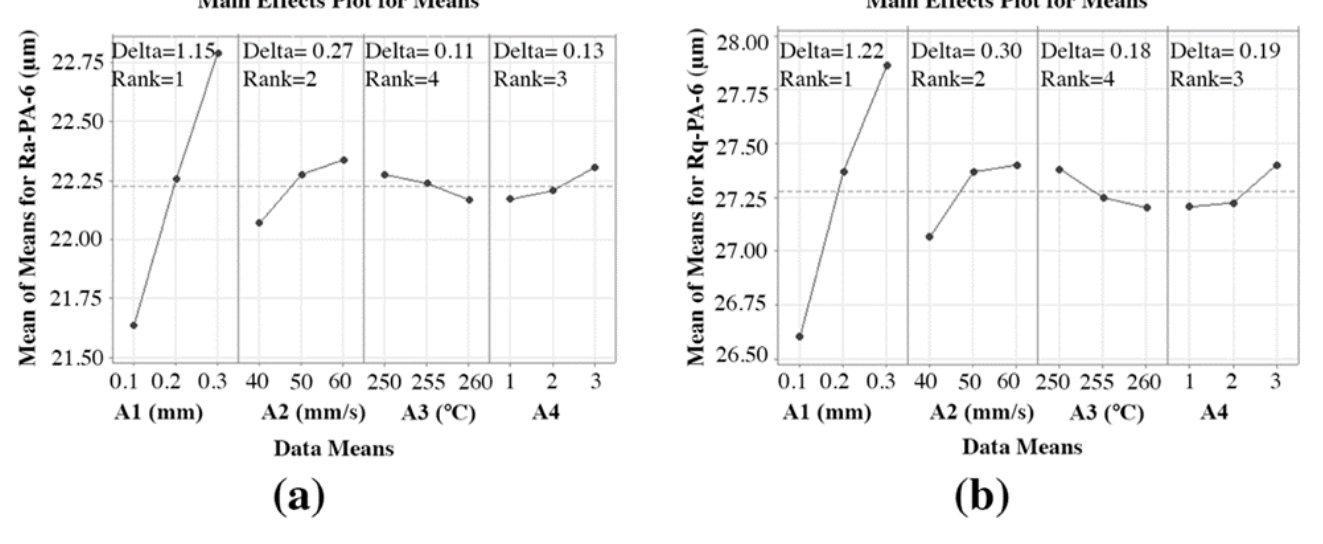
Figure 8. Effect of FFF parameters on polymers: ( a ) Ra-PA-6 and ( b ) Rq-PA-6.